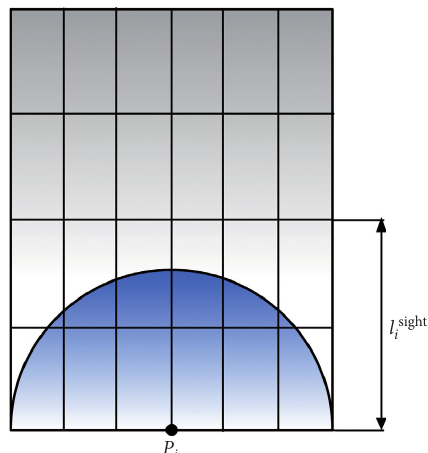
Figure 4: Distribution of intermediate destination